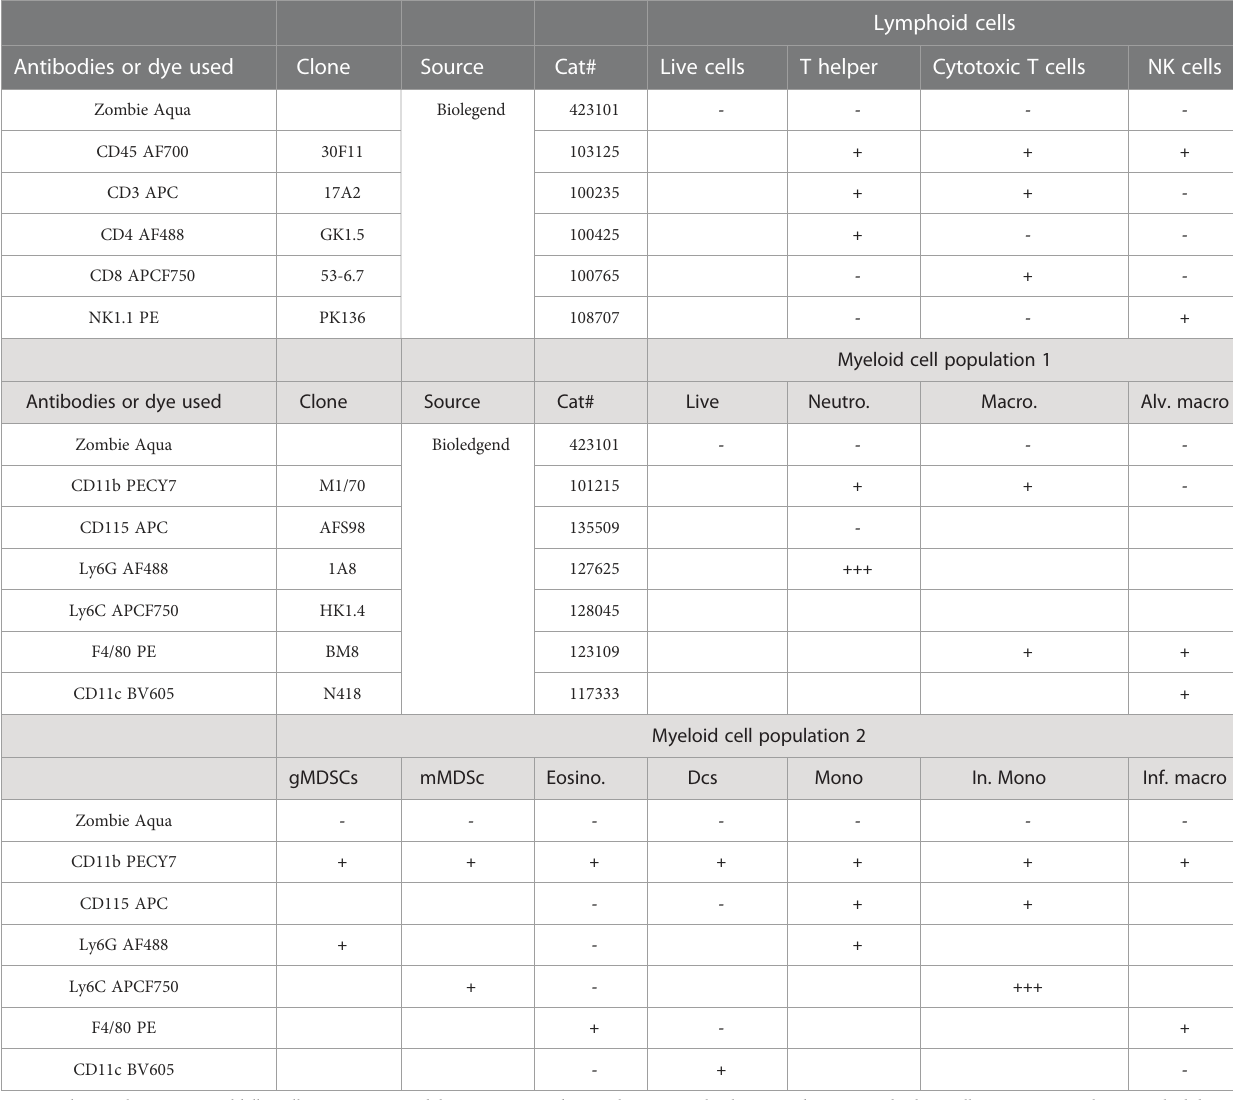
TABLE 1 Summary table of the antibodies used for multicolor fl ow cytometry in this study and the gating strategies that were applied for the data